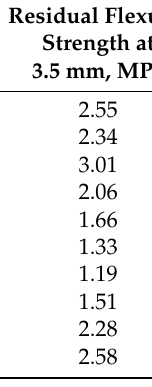
Figure 4. The function of stress and CMOD of concrete with CR ( a ), LCR ( b ) and GLCR&FCR ( c ). Table 4. Work and fracture energy used to break the specimens.